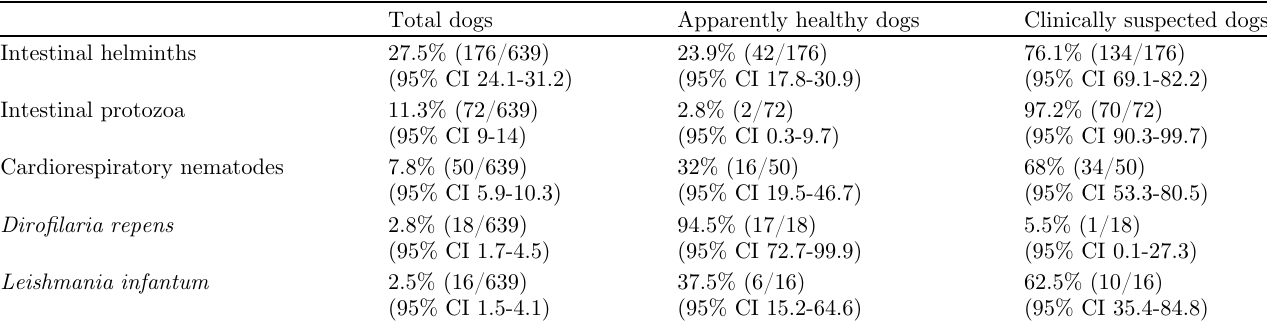
Table 1. Prevalence and 95% con fi dence interval (CI) of intestinal, cardiorespiratory and vector-borne parasites identi fi ed in the total number of examined dogs (639) and in the same dogs separated into apparently healthy or clinically suspect dogs on the basis of clinical